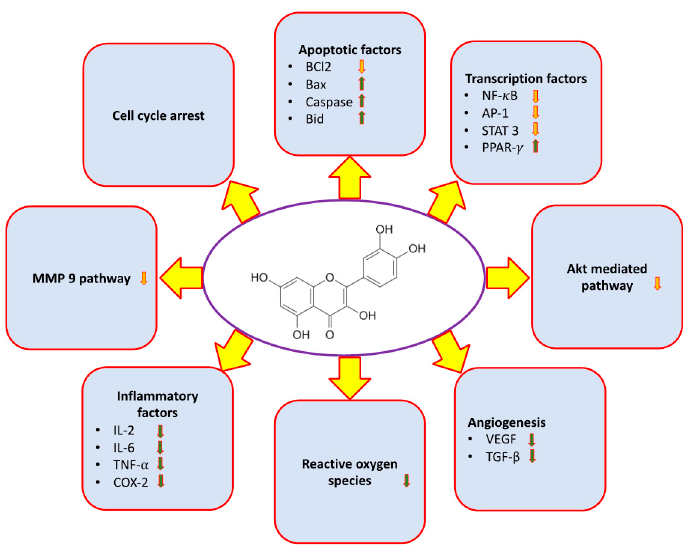
Figure 2. Quercetin shows role in the inhibition of cancer through the modulation of cell signaling